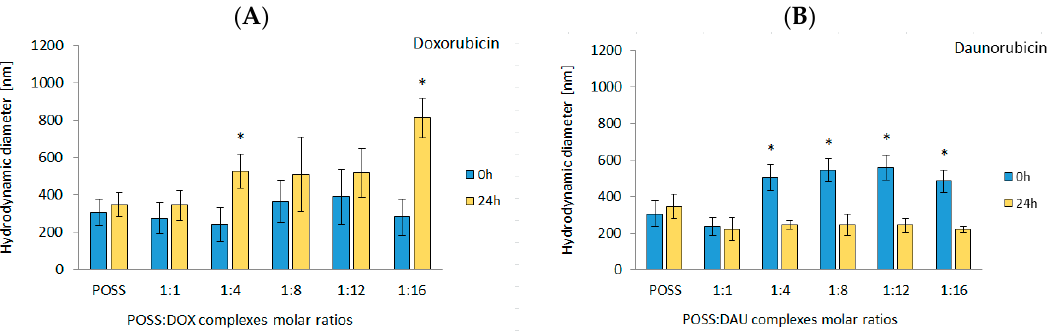
Figure 4. Hydrodynamic diameters of POSS:DOX ( A ) and POSS:DAU ( B ) complexes at different molar ratios after addition of POSS and after 24-h incubation. Data are presented as a percentage of control ± standard deviation (SD); * p < 0.05 (statistical significance between POSS and POSS:DOX; POSS:DAU complexes). Abbreviations: DAU, daunorubicin; DOX, doxorubicin; POSS, polyhedral oligomeric silsesquioxanes.